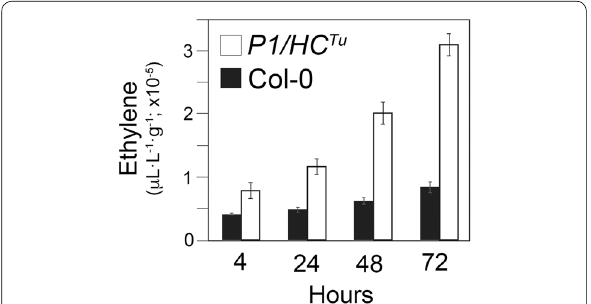
Fig. 9 Time courses of endogenous ethylene detection in Col‑0 and P1/HC Tu plants. The bars represent standard deviations ( n